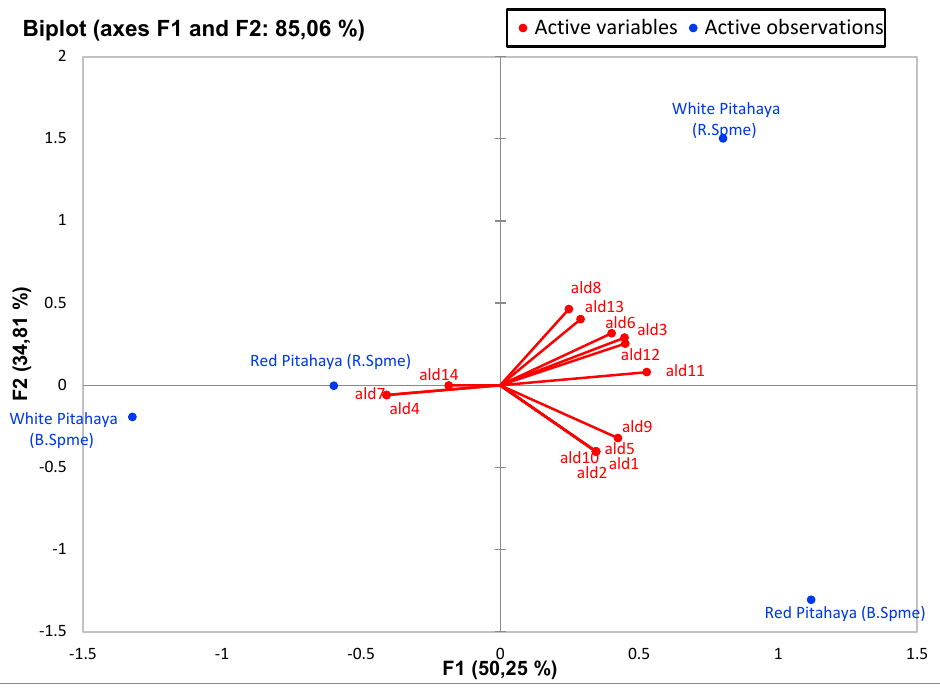
Figure 5. Biplot graph (scores and loading plots) obtained from Principal Component Analysis for aldehydes from volatile compounds in red-white pitaya. ald1: 2 octenal, ald2: 2,4 nonad ı enal, ald3: 2-Decenal, (E)-, ald4: 2-furancarboxaldehyde, ald5: 2-heptenal, (Z)-, ald6: 2-oxo- Propanal, ald7: 3- methyl-Benzaldehyde, ald8: caprylaldehyde, ald9: hexanal, ald10: Non-2(E)-enal, ald11: nonanal, ald12: octanal, ald13: Trans-2-Dodecenal, ald14: trans-2-Undecenal.